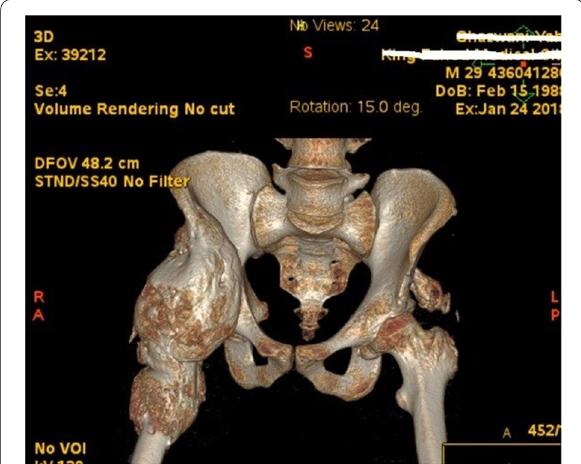
Fig. 1 Patient with heterotopic ossification following brain injury. (3D osseous CT showing G2 Lt hip heterotopic ossification and G4 RT hip heterotopic ossification for a patient with long-standing bed bound stay following brain injury)